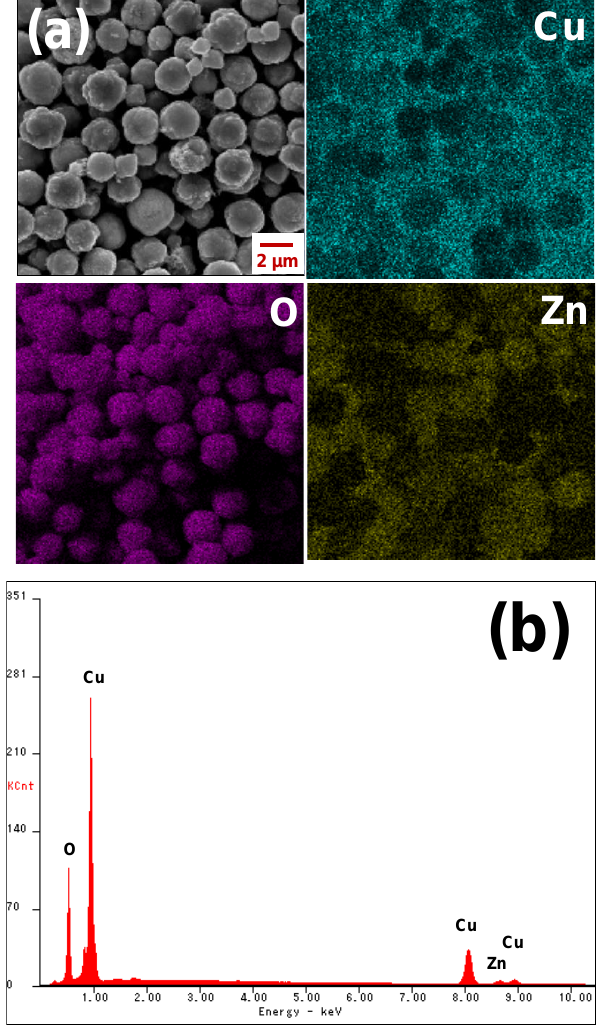
Figure 5. ( a ) Elemental mapping and ( b ) EDS spectra of sample S6.